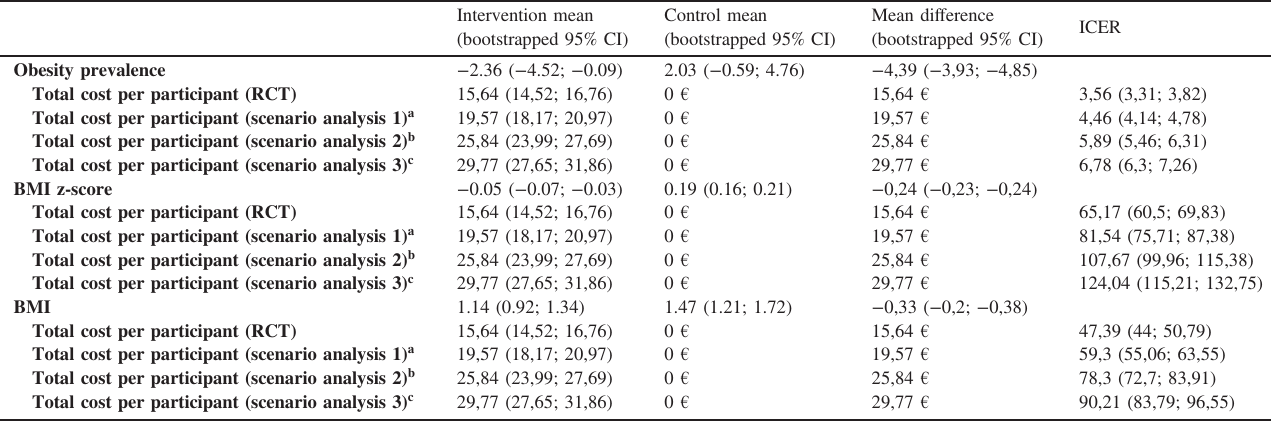
Table 2. Cost-e ff ectiveness and cost-utility analysis in boys